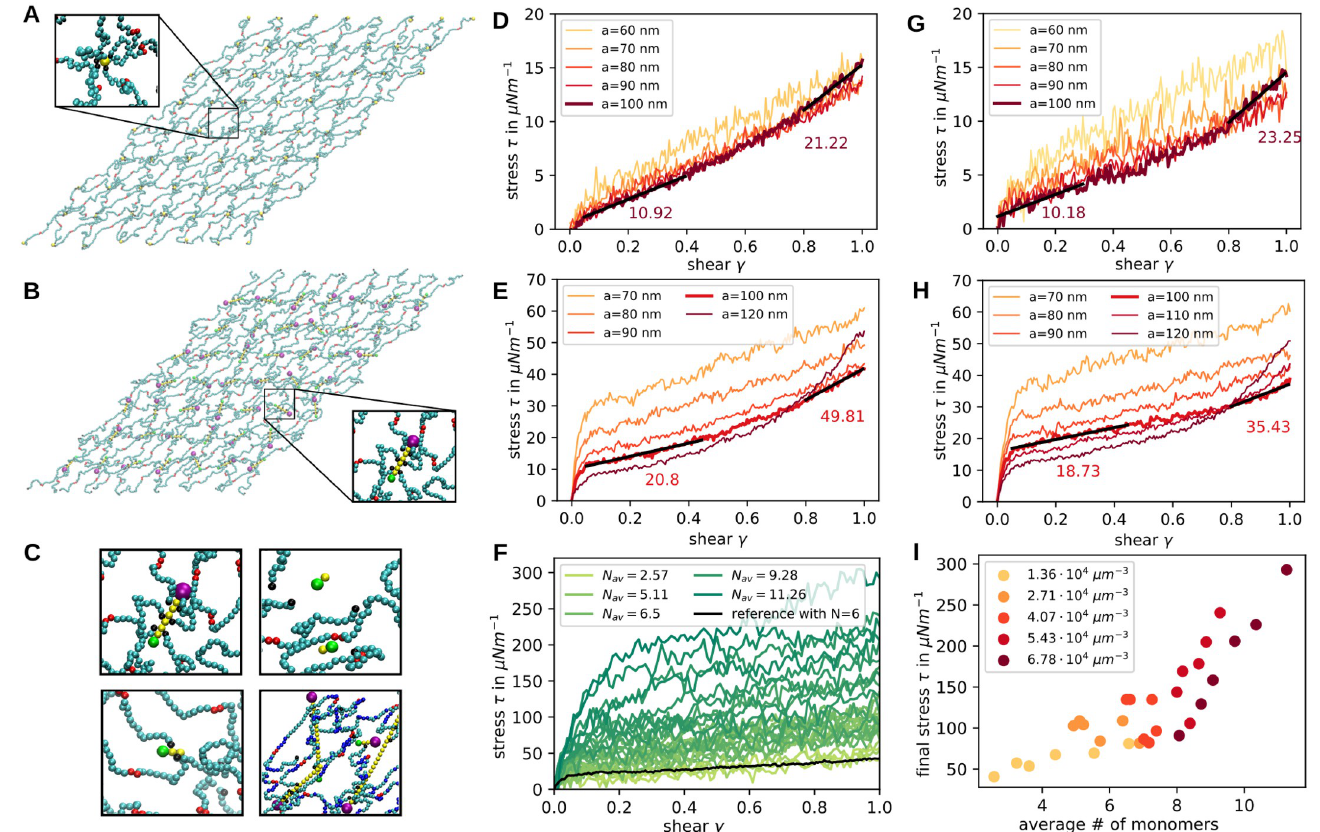
Fig 4. Network shear response. (A) Snapshot of the simulation at shear 1.0 in the x-direction. Junctional points are modelled as single actin particles. (B) Same as in a but now the junctions are modelled as full actin filaments. (C) Examples of actin filaments at different lengths within the network. (D-H) Stress is plotted against shear extracted from simulations with a shear rate of 3 � 10 5 s − 1 . Each line corresponds to the average of 10 simulations. In D and G single particles are used as actin junctions whereas in E and H the proper actin filaments are implemented. In D and E the spectrin filaments are modelled without angle potentials and the anchoring sites are free to diffuse in the bilayer plane. In G and H the spectrin angle potential constant has a strength of 4.28 kJ mol − 1 and the anchoring sites possess a reduced diffusion due to anchoring in the bilayer. (F) The stress response to shearing is plotted for different average filament lengths as indicated in the legend. Sheared networks are taken from all different concentrations and time points of simulations with capping proteins. The black line is for a perfect network with exactly N = 6 actin beads per filament and serves as a reference. (I) The final stress from C is now plotted against the average filament length with the colours indicating the different initial concentrations as shown in the